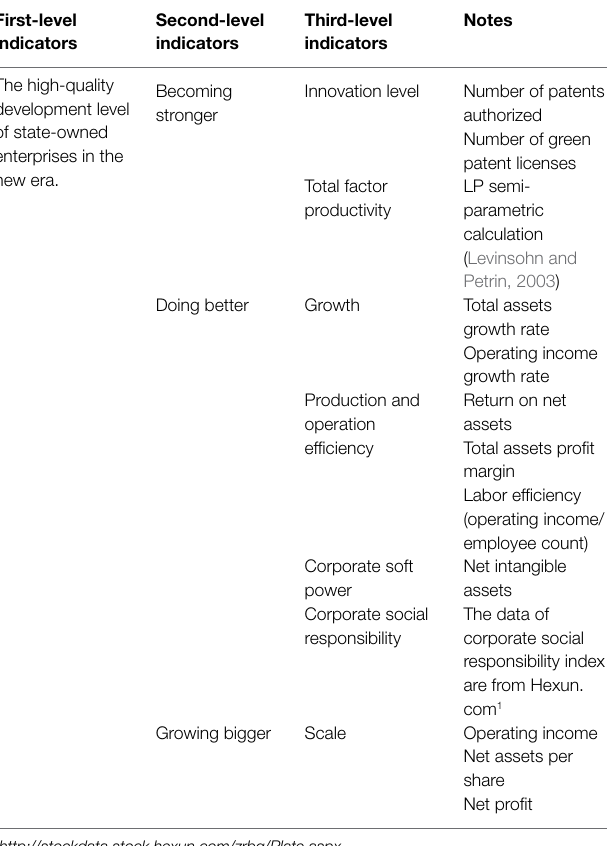
TABLE 1 | Index of high-quality development level of state-owned enterprises in the new era. First-level indicators